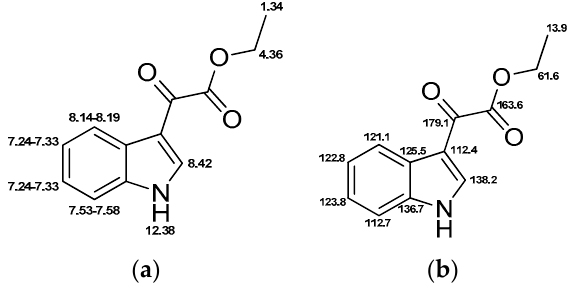
Figure 14. Chemical structure of 10 and relevant NMR shifts for ( a ) 1 H-NMR; and ( b ) 13 C-NMR.